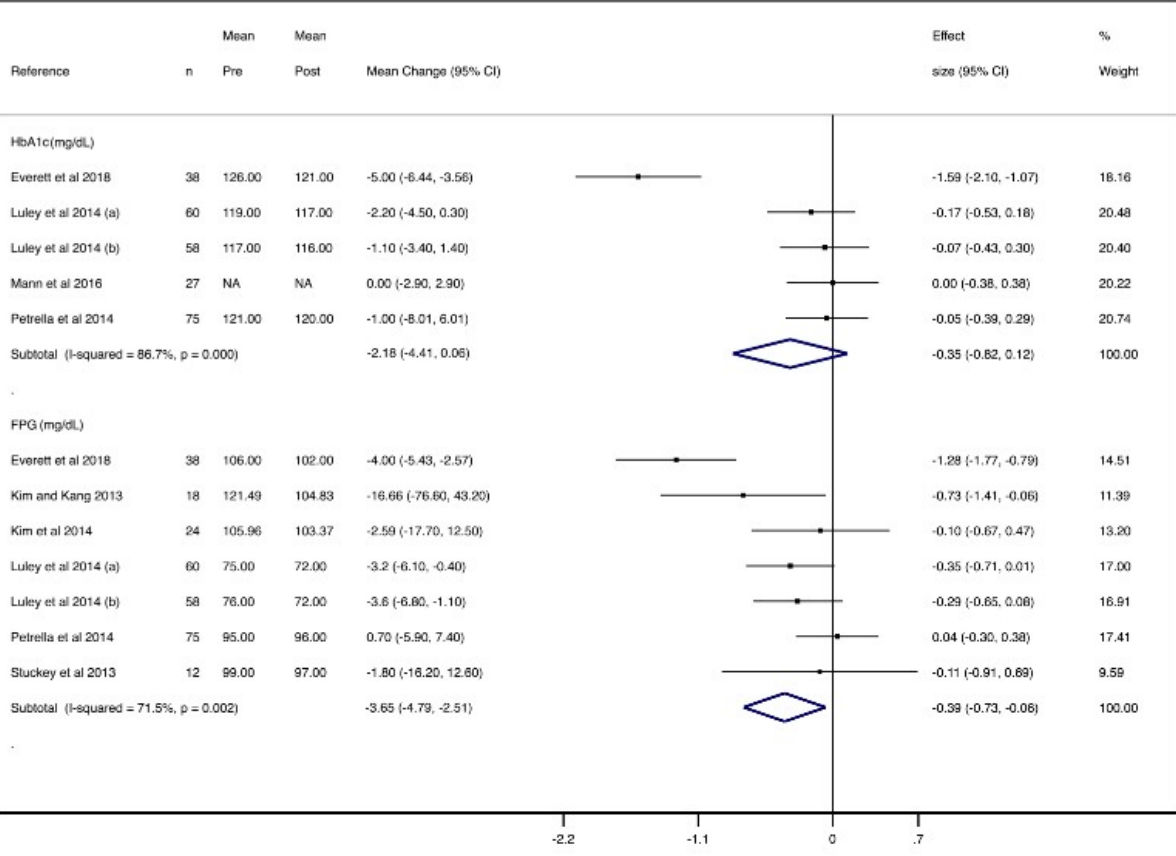
Figure 5. Forest plot of meta-analysis of mean changes and effect sizes for glucose tolerance parameters. FPG: fasting plasma glucose; HbA 1c : glycated hemoglobin A 1c